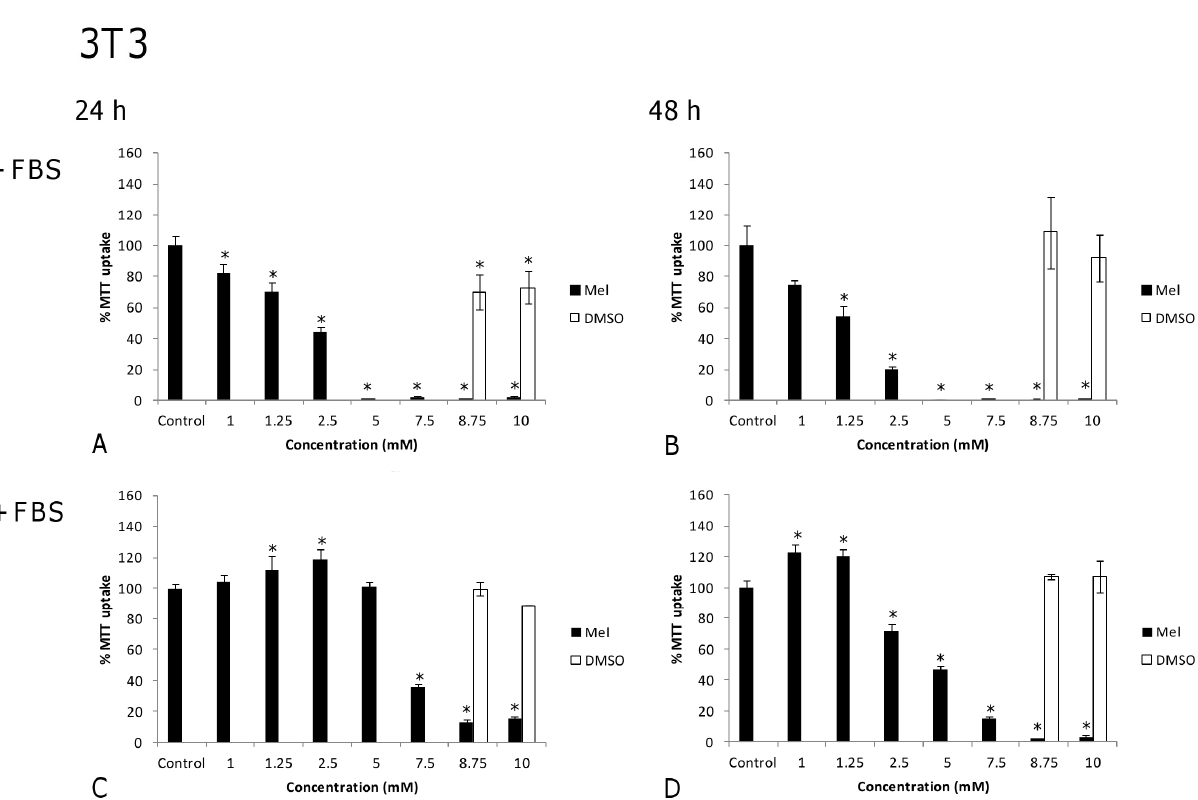
Figure 4. Fibroblast cell line (3T3): Effects of melatonin on cell viability (expressed as the percentage of MTT uptake with respect to the untreated control), in a high concentration range, in the absence ( A and B ) or the presence ( C and D ) of fetal bovine serum (FBS) after 24 ( A and C ) and 48 h ( B and D ) of treatment. DMSO vehicle controls were performed for each melatonin concentration, although for terms of clarity only the two highest concentrations are represented. Statistically significant differences compared to controls are marked with asterisks. (* indicates p < 0.05, ANOVA followed by Dunnett’s post hoc